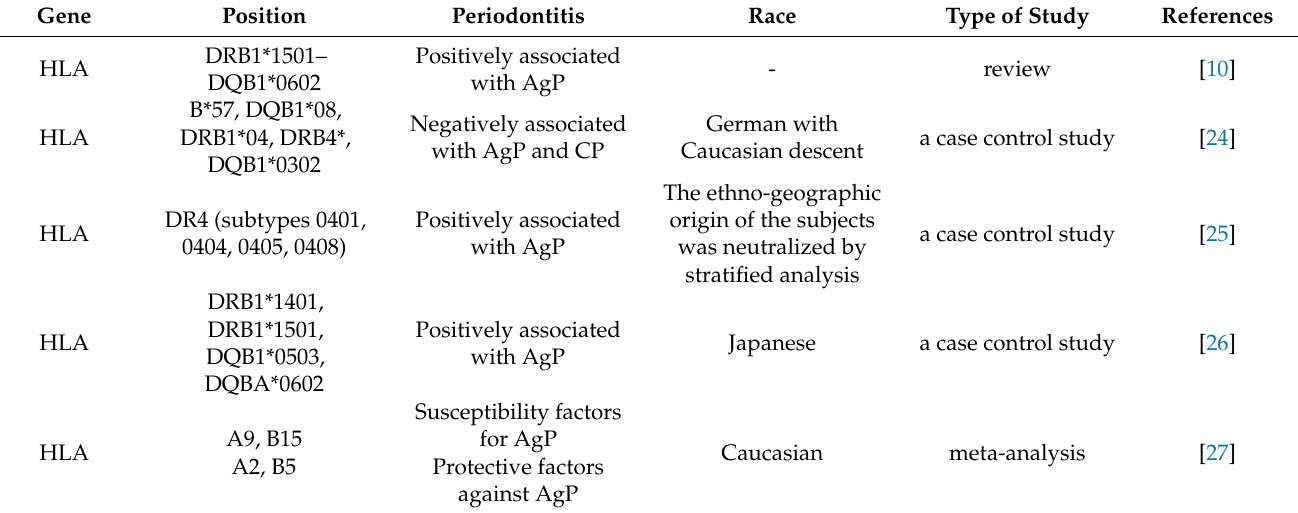
Table 1. Human leukocyte antigens (HLA) gene polymorphisms related to chronic and aggressive